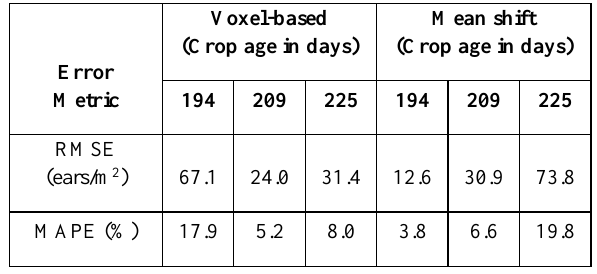
Table 5 Error in ear counts from the automatic detection methods calculated using the manual counting from the field as